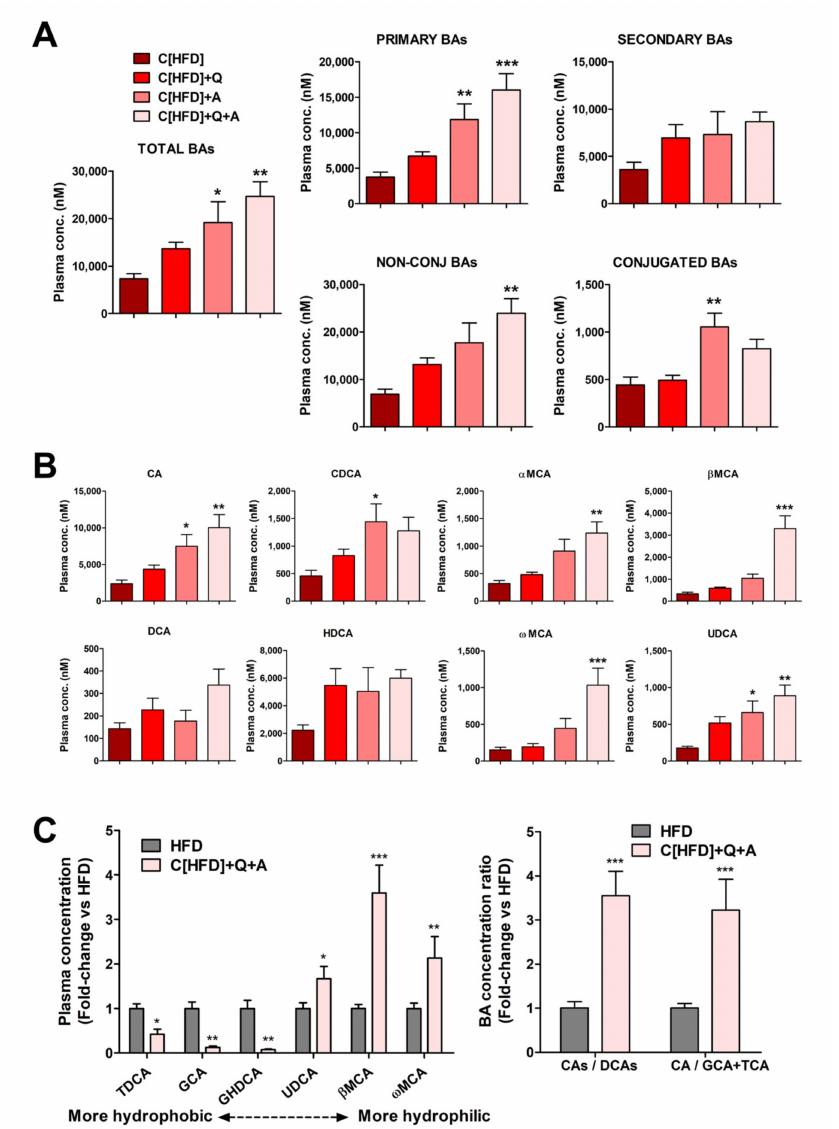
Figure 6. Effect of diet, quercetin and A. muciniphila supplementation on plasma BA levels in a juvenile rat NAFLD model. ( A ) Concentrations (nM) of total, primary, secondary, conjugated and unconjugated BAs. ( B ) Specific primary (CA, CDCA and muricholic acids α MCA and β MCA) and secondary (DCA, HDCA, ω MCA and UDCA) BA concentrations. ( C , left ) Relative plasma concentration of hydrophobic and hydrophilic Bas in HFD group and in HFD group after control diet supplemented with quercetin and A. muciniphila . ( C , right ) BA concentration ratios of primary CA+TCA+GCA vs. secondary derivatives DCA+TDCA+GDCA, and CA vs. conjugated CA species (GCA+TCA), in HFD group and in HFD group after control diet supplemented with quercetin and A. muciniphila . Data represent mean of absolute values ± SEM ( A , B ), or mean of normalized to HFD values ± SEM ( C ). * p < 0.05, ** p < 0.01, *** p < 0.001, vs. C[HFD] ( A , B ) or vs. HFD group ( C